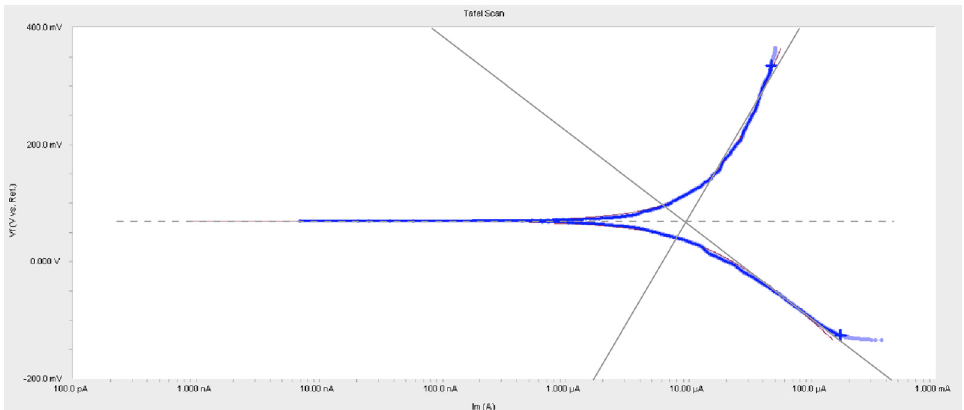
Figure 11. Accelerated corrosion test set ‐ up.